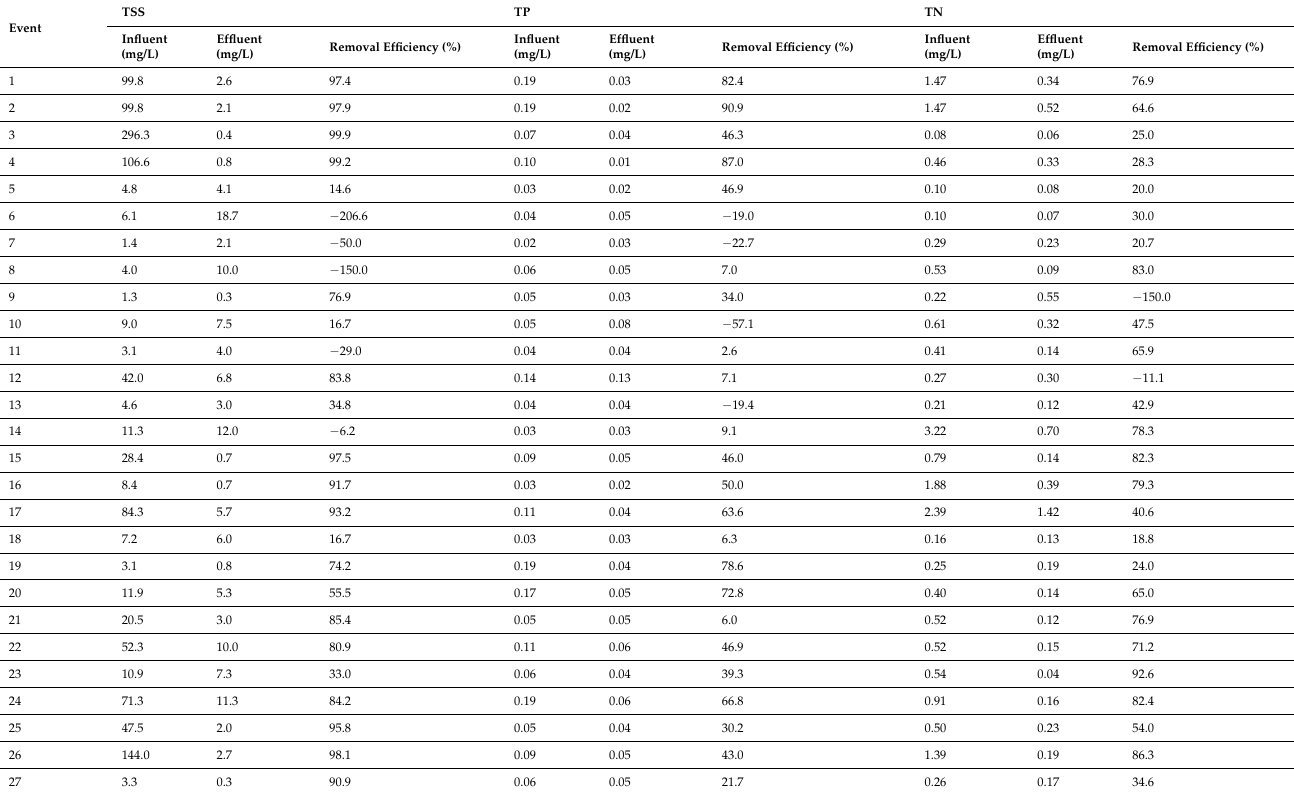
Table A8. Performance of MBT for Phase 3 (Field Study).